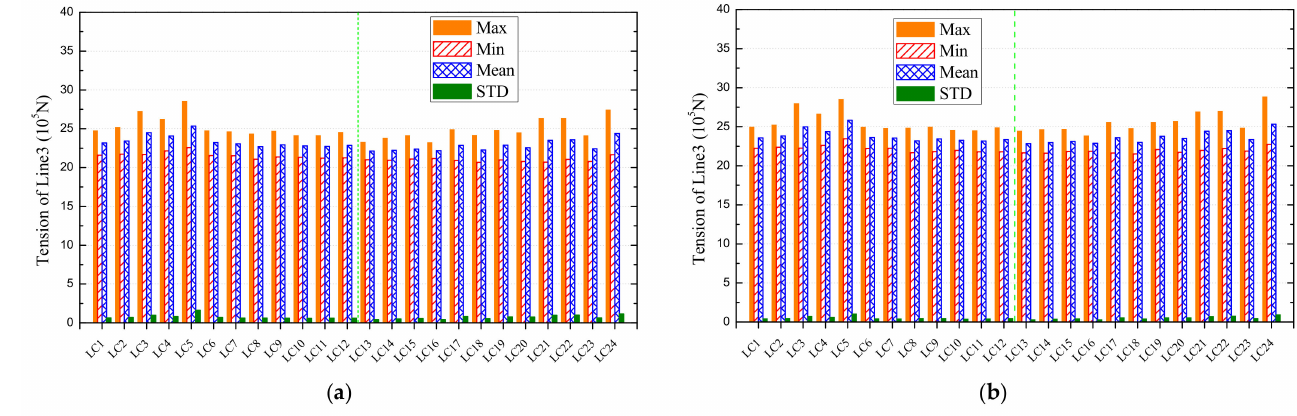
Figure 22. Statistics of mooring tension of line 3 for ( a ) without current; ( b ) with